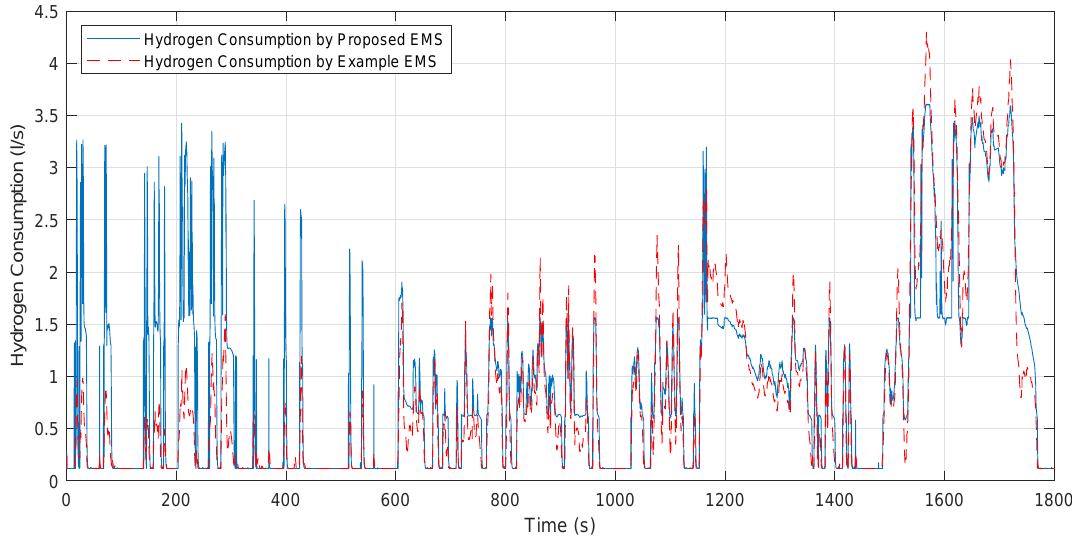
Figure 17. Comparison of fuel-cell hydrogen